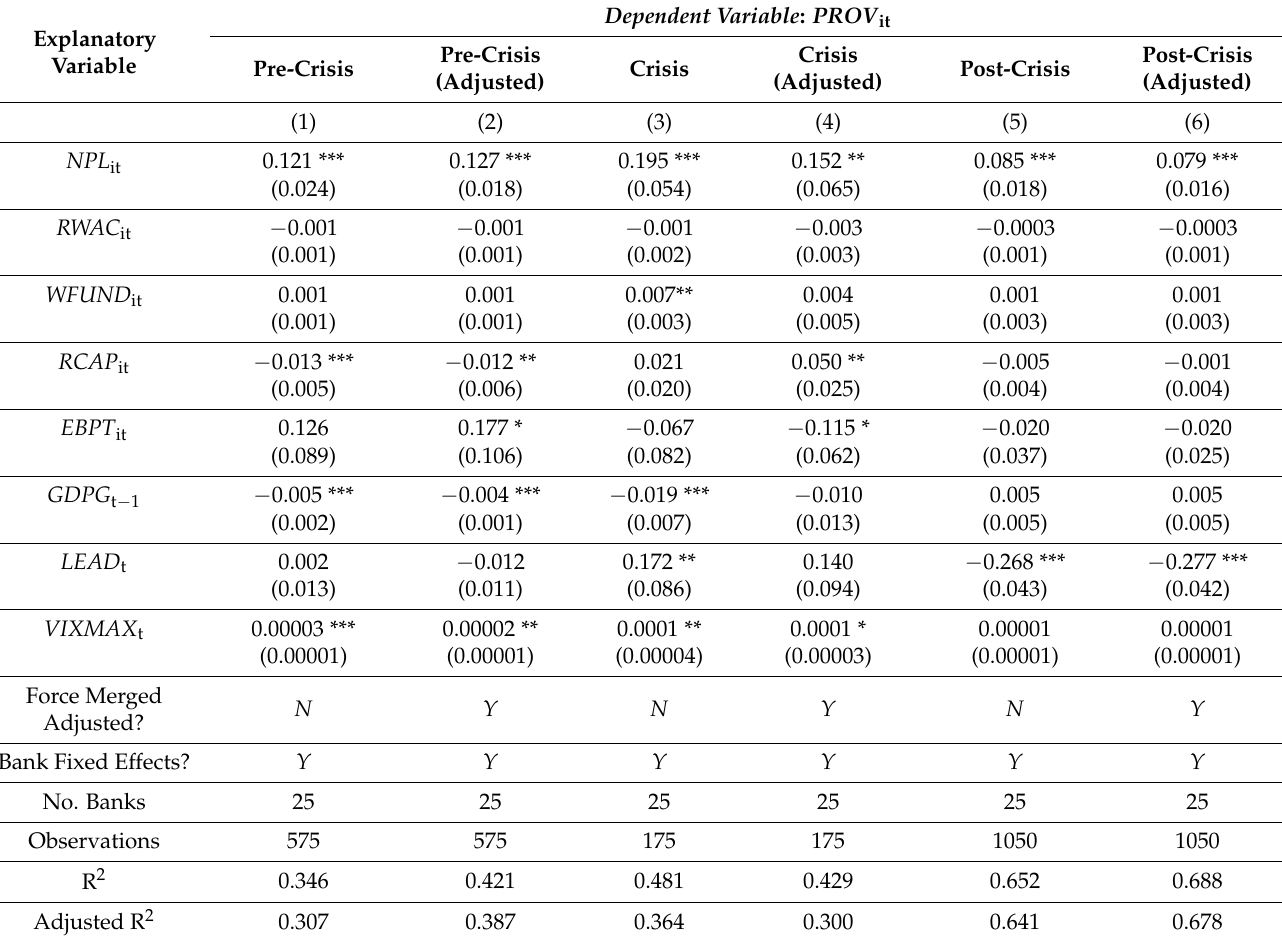
Table 5. How do U.S. Bank Holding Company Provisions Vary over the Business